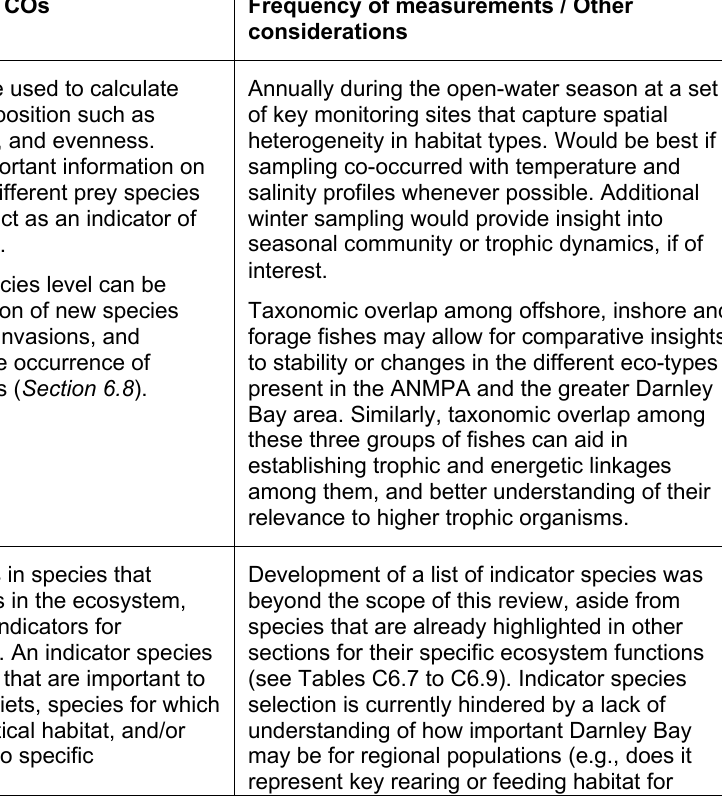
Table C6.5. Key measurement parameters for monitoring offshore fish community composition, structure, and function (Section 6.5).